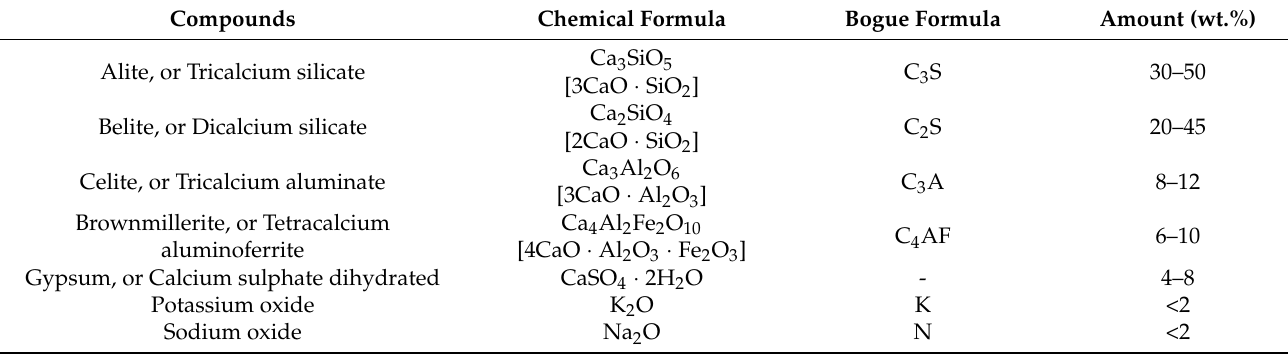
Table 1. Main components of an OPC.